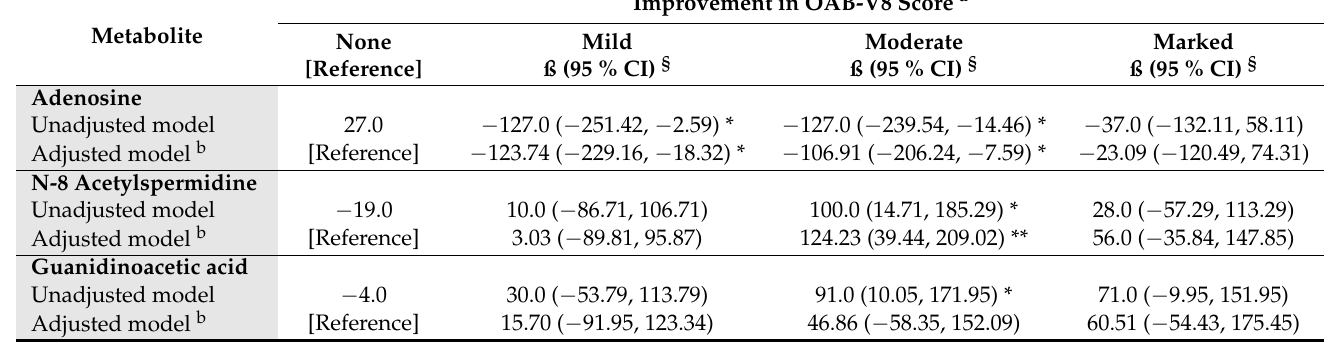
Figure 2. Percentage of change in urinary metabolite levels by improvement in OAB-V8 score: None (no improvement) < 8-point change, Mild = 8–15-point change, Moderate = 16–23-point change, Marked ≥ 24-point change. p values were generated by comparing the Mild, Moderate, and Marked groups to the None group as shown in the figure. Table 2. Relative percent difference in metabolite levels during follow up when comparing the Mild, Moderate and Marked OAB-V8 score groups to the no-improvement in OAB-V8 score (None: our reference